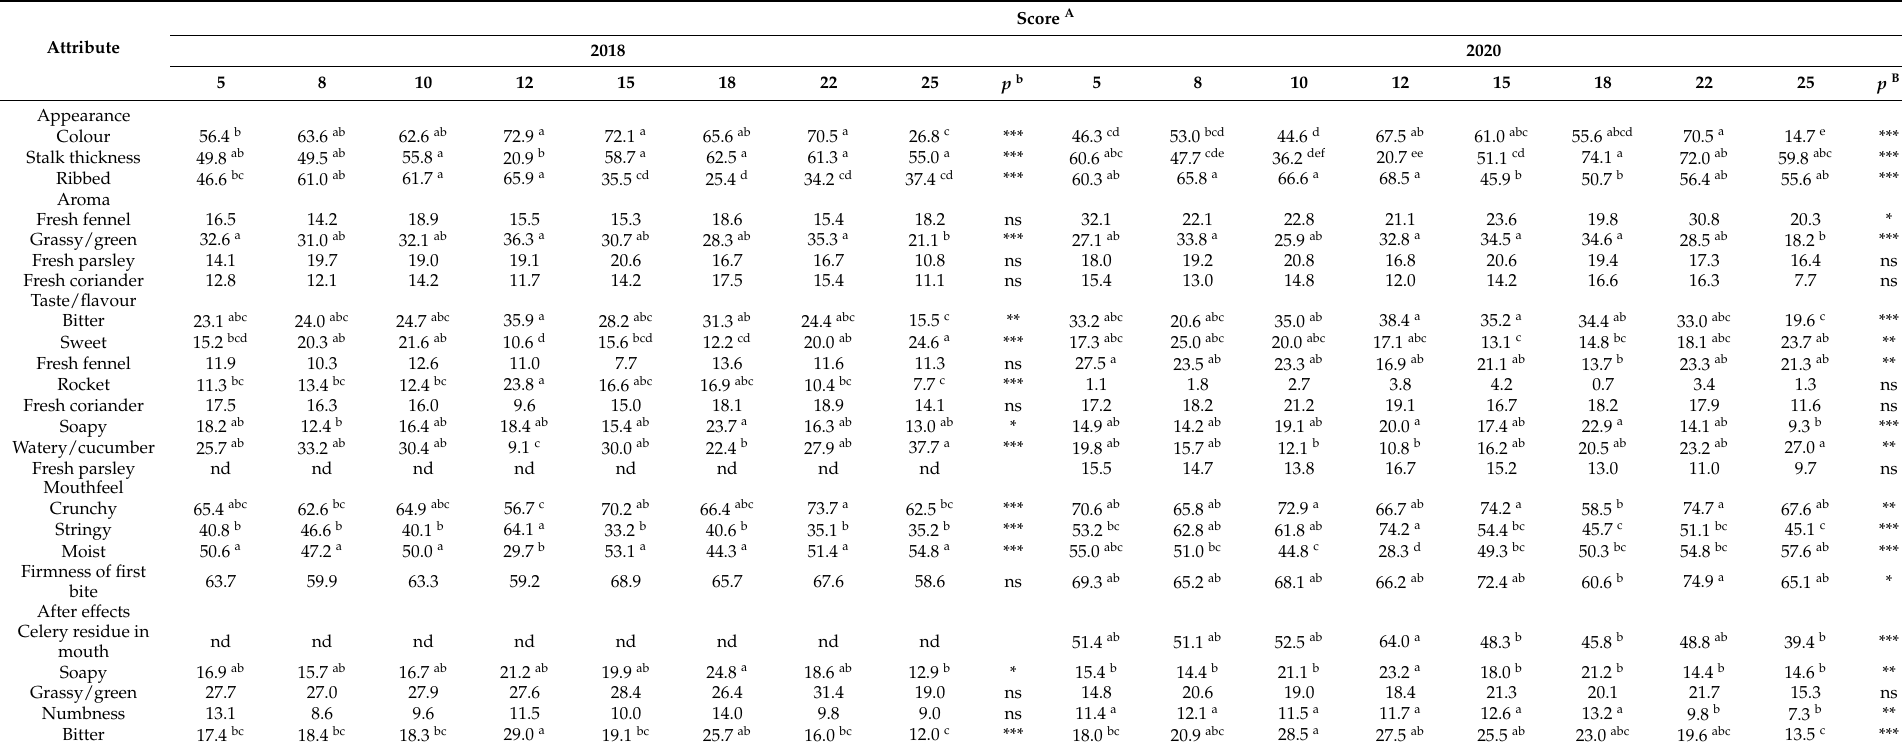
Table 2. Mean panel scores for sensory attributes of the eight celery samples harvested in 2018 and